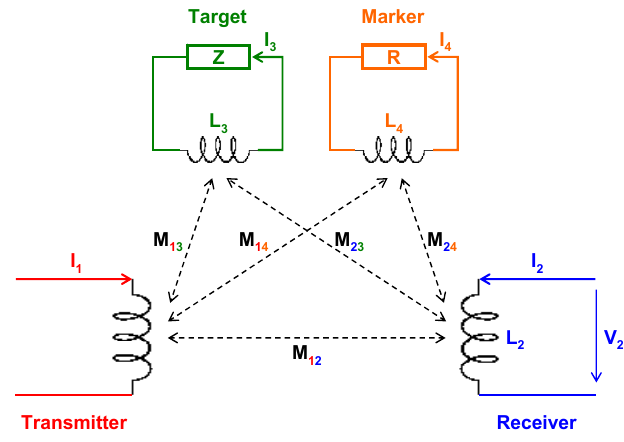
Fig. 2: Equivalent measurement model for a marked biological target in biomedical MITS. Z and R represent the impedance and resistance of the target and marker, respectively; L # , I # and V # represent the inductance, current and voltage, respectively, with respect to the indexed component; M ## represents the mutual inductance between the two indexed